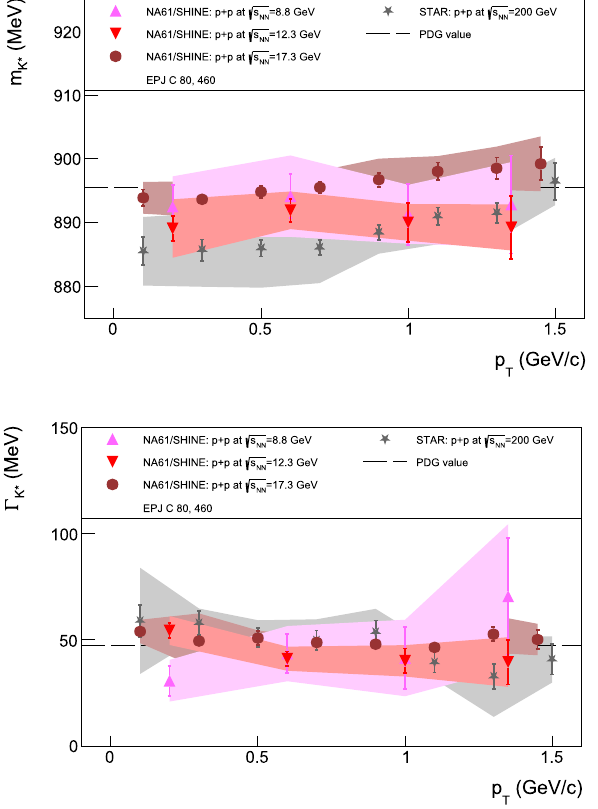
Fig. 10 The transverse momentum dependence of mass and width of K ∗ ( 892 ) 0 (or K ∗ 0 )mesonsobtainedin p+p collisionsbyNA61/SHINE (this analysis and Ref. [9]) and STAR [11]. For STAR the averaged ( K ∗ 0 ) measurements of K ∗ ( 892 ) 0 and K ∗ ( 892 ) 0 are presented. The horizontal lines represent PDG values [28]